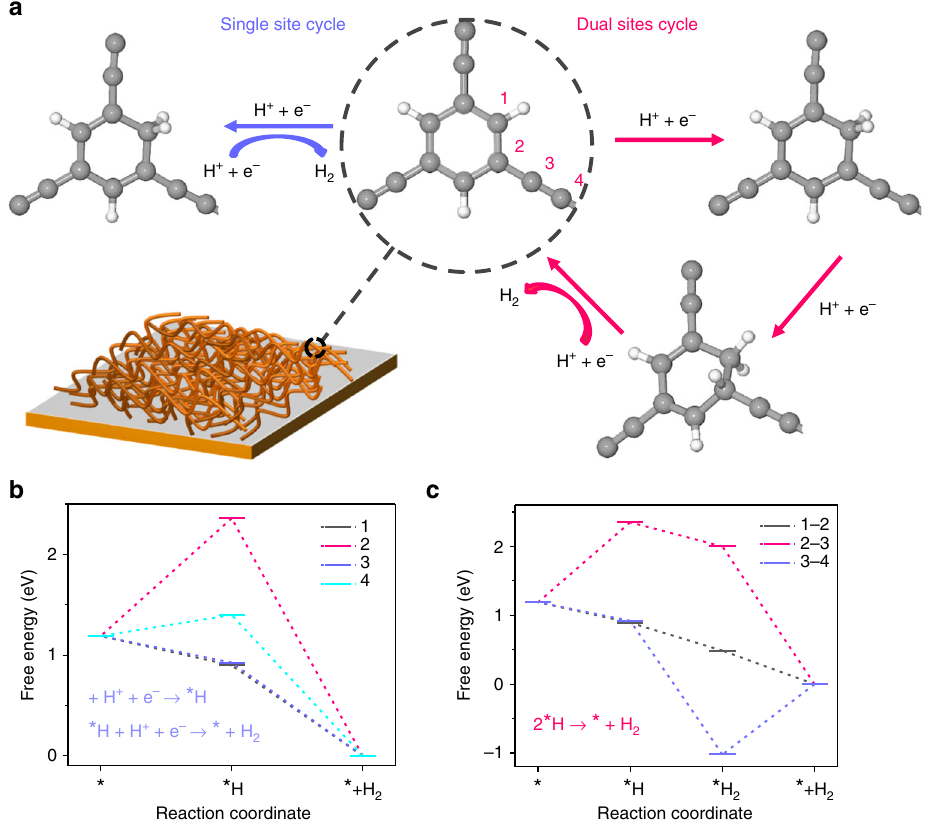
Fig. 6 DFT calculation to investigate the H 2 evolution active sites. a Reaction cycles and active sites for single and dual sites H 2 evolution from water. b Free-energy variations for H 2 evolution via single site reaction pathway: 1, 2, 3, and 4 denote for different active sites as labeled in a . c Free-energy variations for H 2 evolution via dual sites reaction pathway: sites 1 – 2, 2 – 3, and 3 – 4 denote for different active sites as labelled in a . *Catalyst (i.e., PTEB)